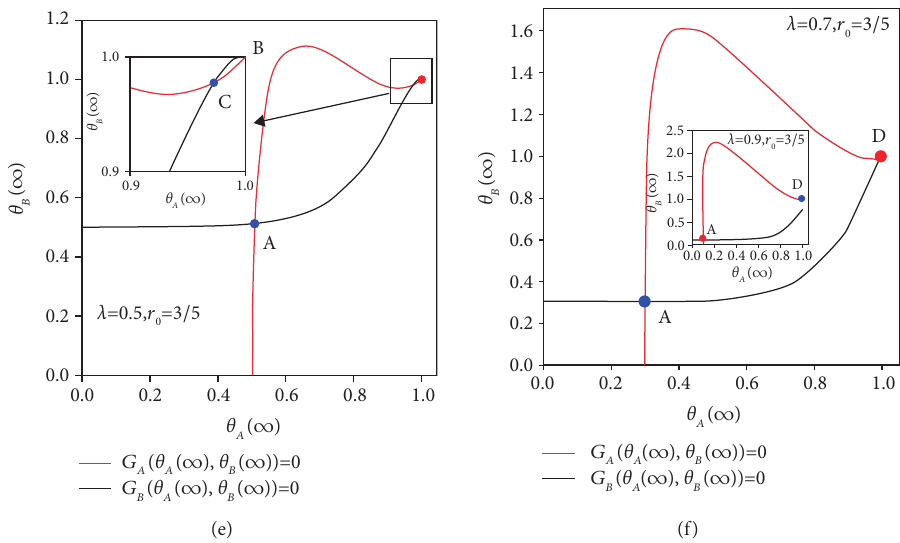
Figure 2: The change of the roots ( θ ( ∞ ) , θ ( ∞ ) ) of equation (27) at p � 0 . 45. The red and blue points are the roots of equation (27). The A B � 1/5, the change of the roots of equation (27) at red points are physically relevant roots and the blue points are other roots. In the case of r 0 (a) λ � 0 . 7533, (b) λ � 0 . 8, (d) λ � 0 . 818, and the inset of (d) λ � 0 . 9. (c) The change of the roots of G B ( θ A ( ∞ ) , θ B ( ∞ )) at θ A ( ∞ ) � 1; the inset of (c) shows the change of the roots of G A ( θ A ( ∞ ) , θ B ( ∞ )) at θ B ( ∞ ) � 1, where the intersections of curves and horizontal line are the � 3/5, the change of the roots of equation (27) at (e) λ � 0 . 5, (f) λ � 0 . 71, and the inset of (f) λ � 0 . 83. Other roots. In the case of r 0 parameters: ρ B � 0 . 19, I B � T � 5, k A � k B � 10, c � 1, ε ⟶ 0